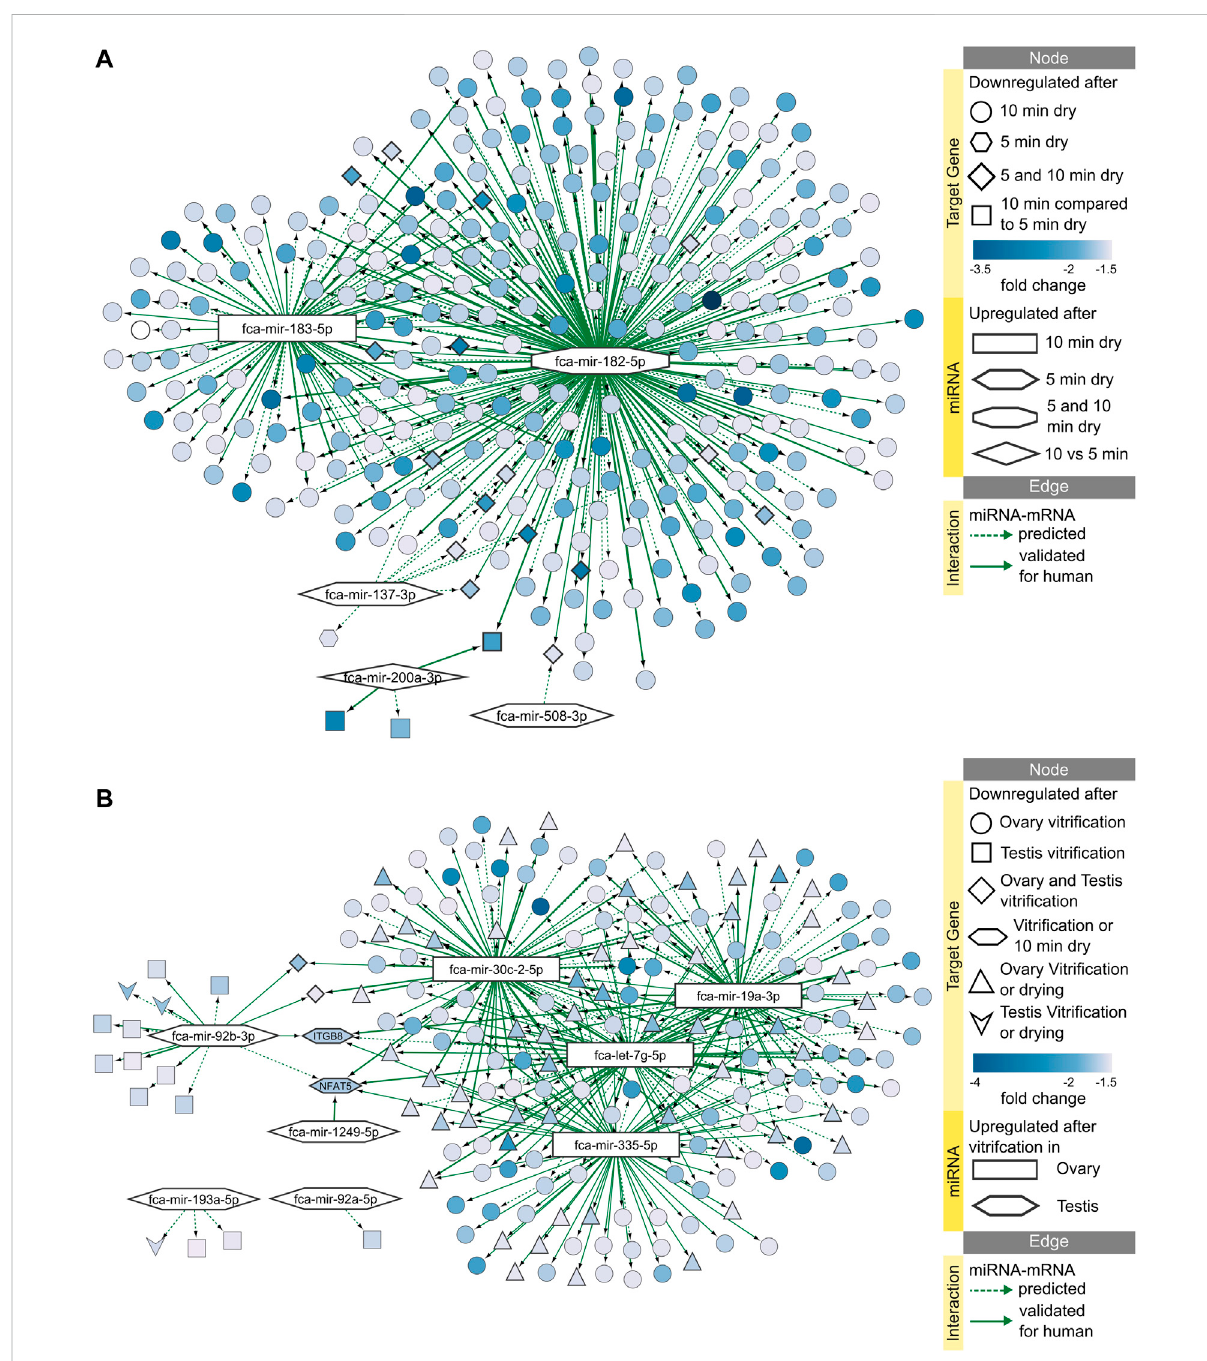
FIGURE 6 miRNA-mRNA predicted interaction networks responding to preservation protocols. Networks of upregulated miRNAs and downregulated target mRNAs after (A) 5 or 10 min dehydration, and (B) vitri fi cation of ovarian or testicular tissues. Interactive networks with corresponding data tables are available in Supplementary Data Sheet